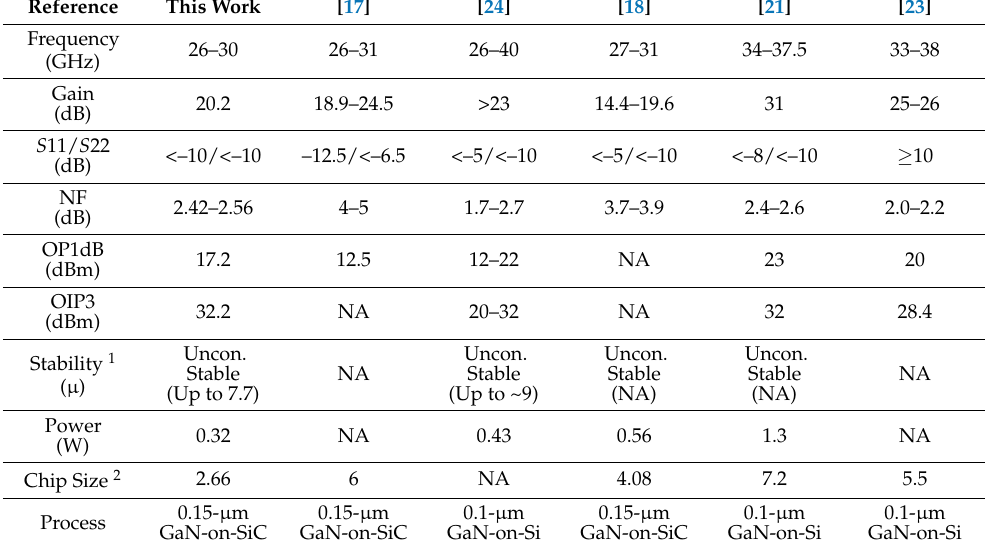
Figure 14. Measured IB OIP3 performance with f 1 = f RF + 20 MHz and f 2 = f RF + 40 MHz. A comparison of the measured performance metrics of the proposed LNA with those of state-of-the-art GaN HEMT LNA MMIC is presented in Table 3. As can be seen from Table 3, the obtained performance of the proposed design, which adopts series inductors is better or comparable to that of other designs for the given power consumption with noticeable stability enhancement. Table 3. Performance summary and comparison with previously reported